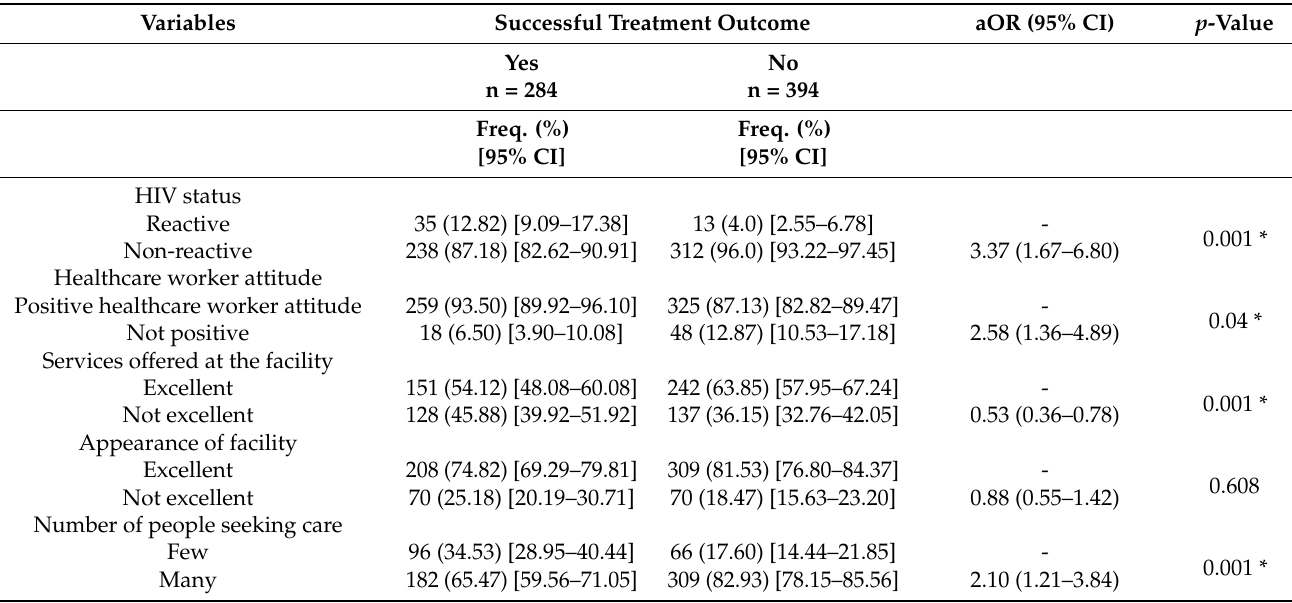
Table 5. Factors associated with the number of TB treatments received among the respondents stratified by treatment outcome using multivariate logistic